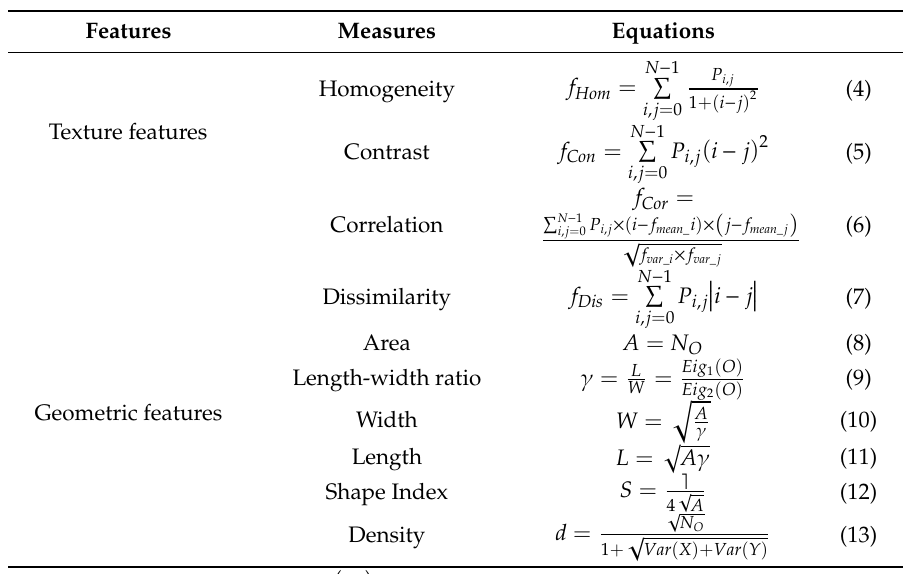
Table 2. The utilized measures of texture and geometric